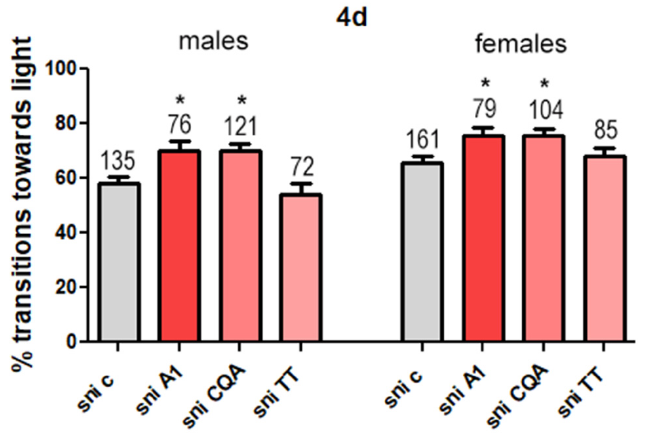
Figure 5. Percentage transitions towards light for sniffer (sni) flies treated with CAW subfraction A1, caffeoylquinic acids (CQAs) and CAST triterpenes (TTs). Sniffer mutants were fed yeast paste (c) or yeast paste supplemented with subfraction A1, CQAs or TTs for 4 days. Fast phototaxis was performed with flies in groups of 10–20 flies and separated by experimental group and sex. The number of flies tested is indicated above the bars. Error bars represent SEM. * = p < 0.05.